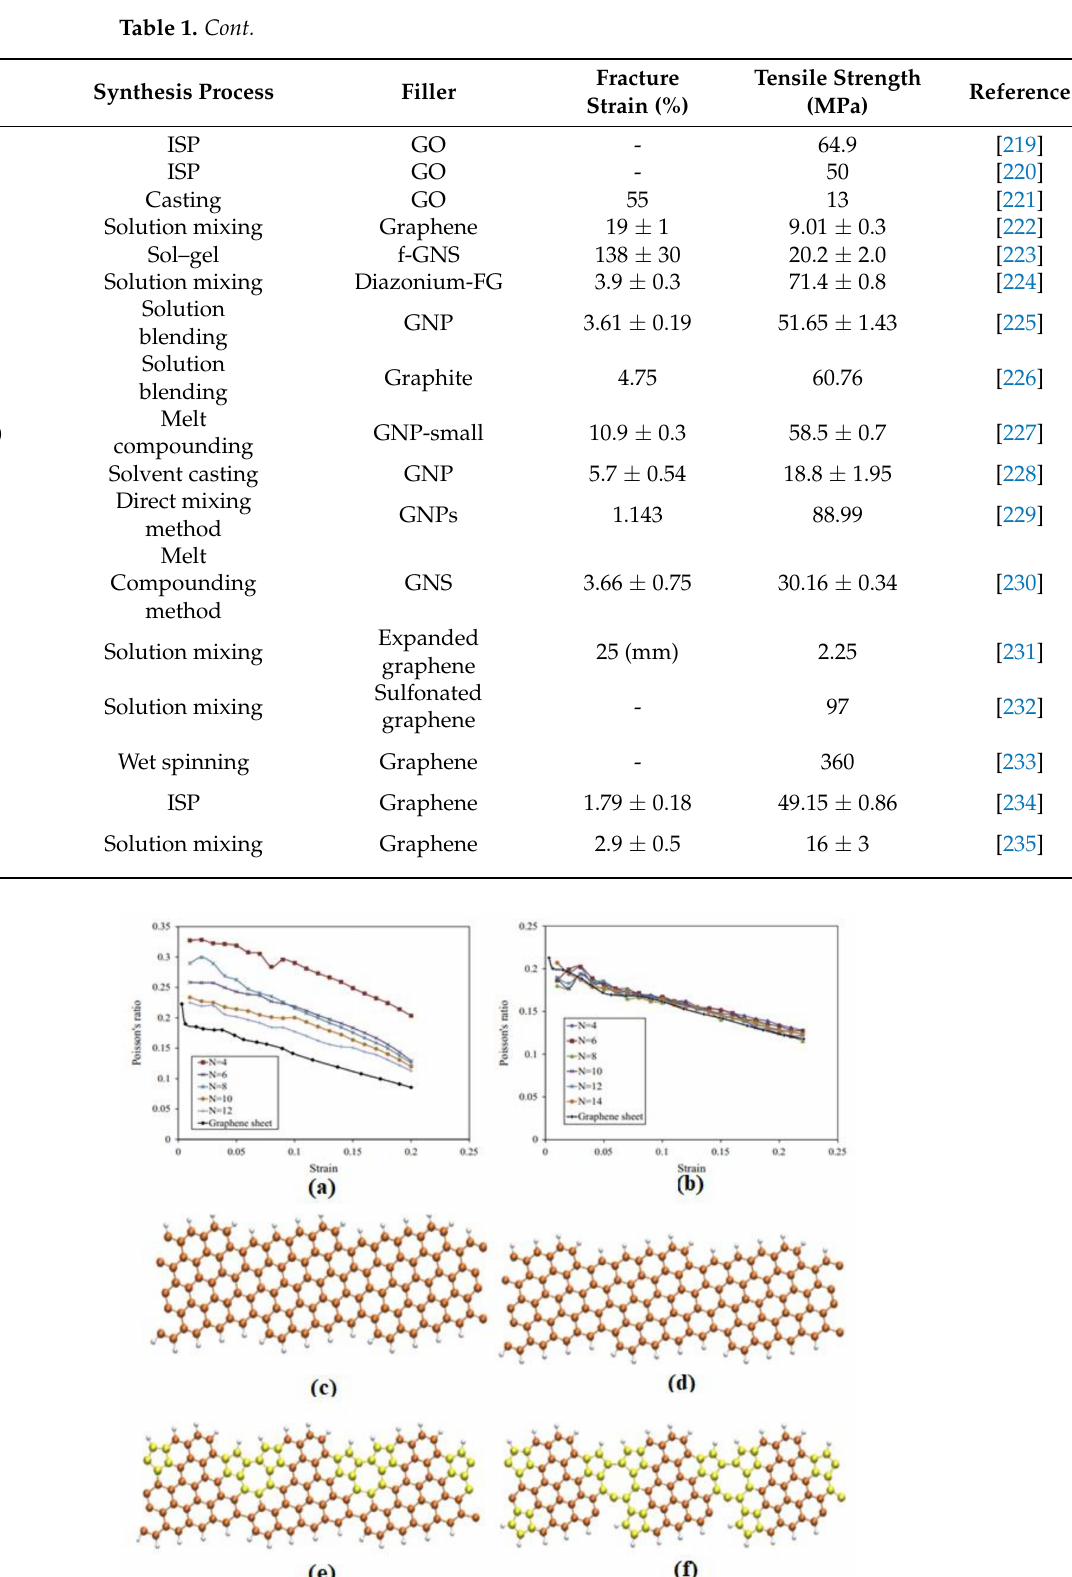
Figure 10. The Poisson’s ratio of graphene nanoribbons with different widths. ( a ) Armchair nanorib- bons and ( b ) zigzag nanoribbons. A graphene nanoribbon with 10:890 chirality under uniaxial tensile loading: ( c ) zero strain, ( d ) 10% strain, ( e ) 12% strain, and ( f ) 16% strain. (Reproduced from [207] with permission. Copyright 2014, Elsevier, Amsterdam, The